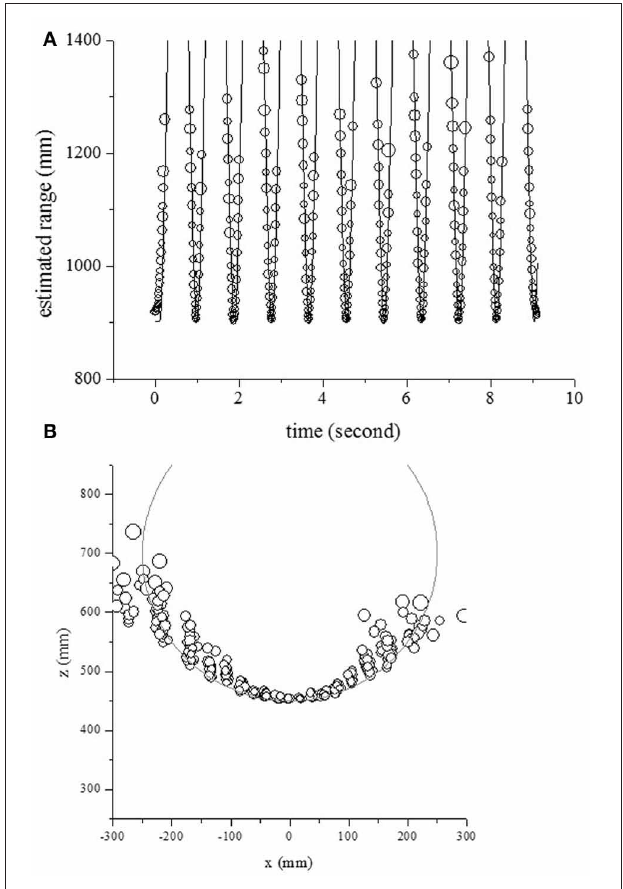
FIGURE 8 | Outputs for one object, moving from side to side with a rotation radius of 250mm. (A) Estimated and actual ranges. (B) Estimated and actual positions in 2D